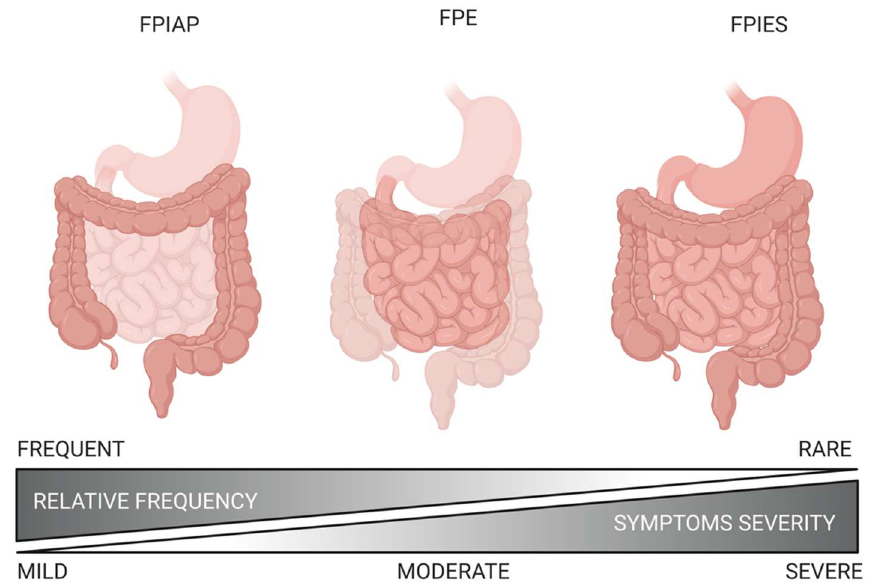
Figure 2. Gastrointestinal organs affected in the different non-IgE-mediated gastrointestinal food allergies. FPIAP and FPE affect the colon and small intestine, respectively, while in FPIES, the whole gastrointestinal tract can be affected. FPE, food protein-induced enteropathy; FPIAP, food protein-induced allergic proctocolitis; FPIES, protein-induced enterocolitis syndrome.